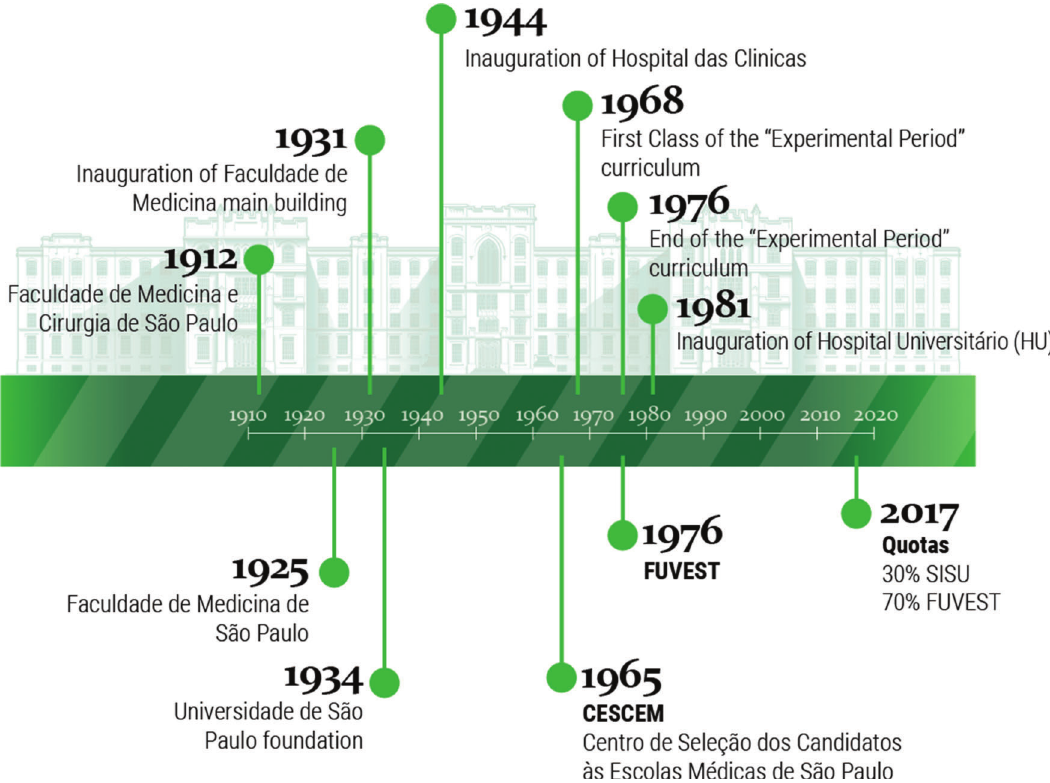
Figure 1 - Important landmarks in USP Medical School history. Please note that CESCEM is an institution created to select candidates to enter medical schools in the state of Sa˜o Paulo (Brazil). ‘‘ Quotas ’’ is used to refer to a Brazilian governmental program of affirmative